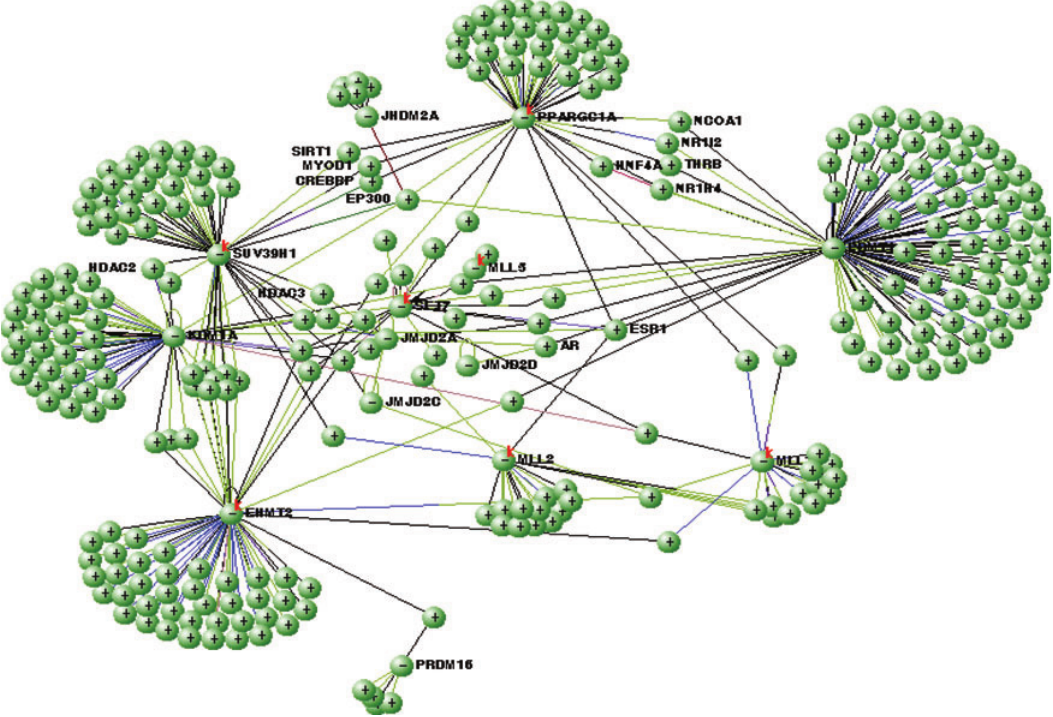
Figure 2 Network predicted by VisANT web-based software (52) using PPARGC1A and putative histone methylases and demethylases listed in Table 1 of Ref. (51)